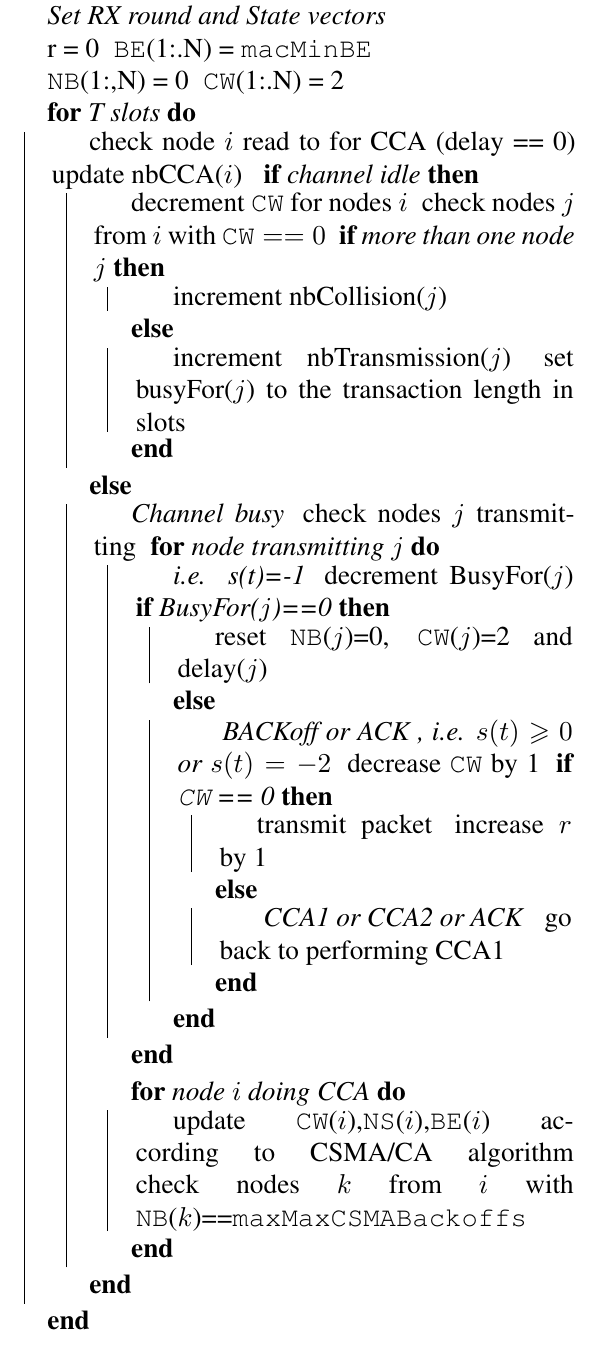
Fig. 6. Slotted CSMA/CA with